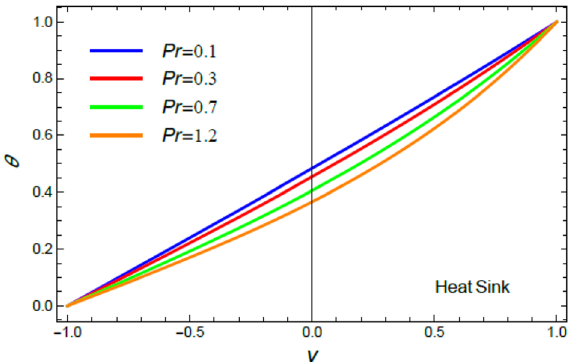
Figure 6. The impact of the Prandtl numeral Pr in the case of heat sink on the temperature profile θ .